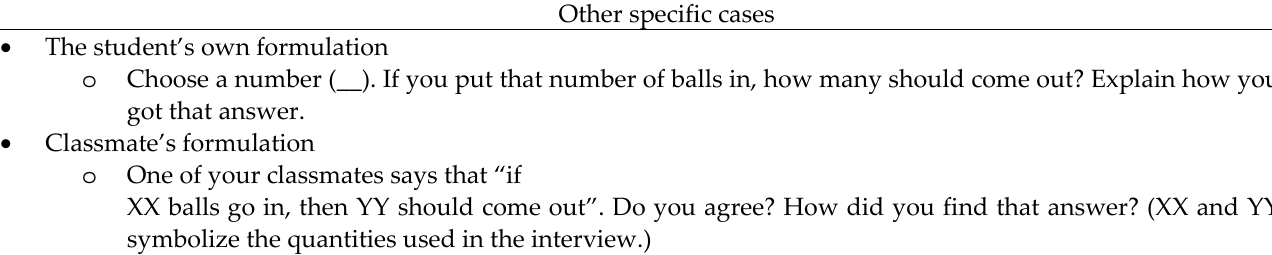
Figure 9. Other specific cases used in the interview.